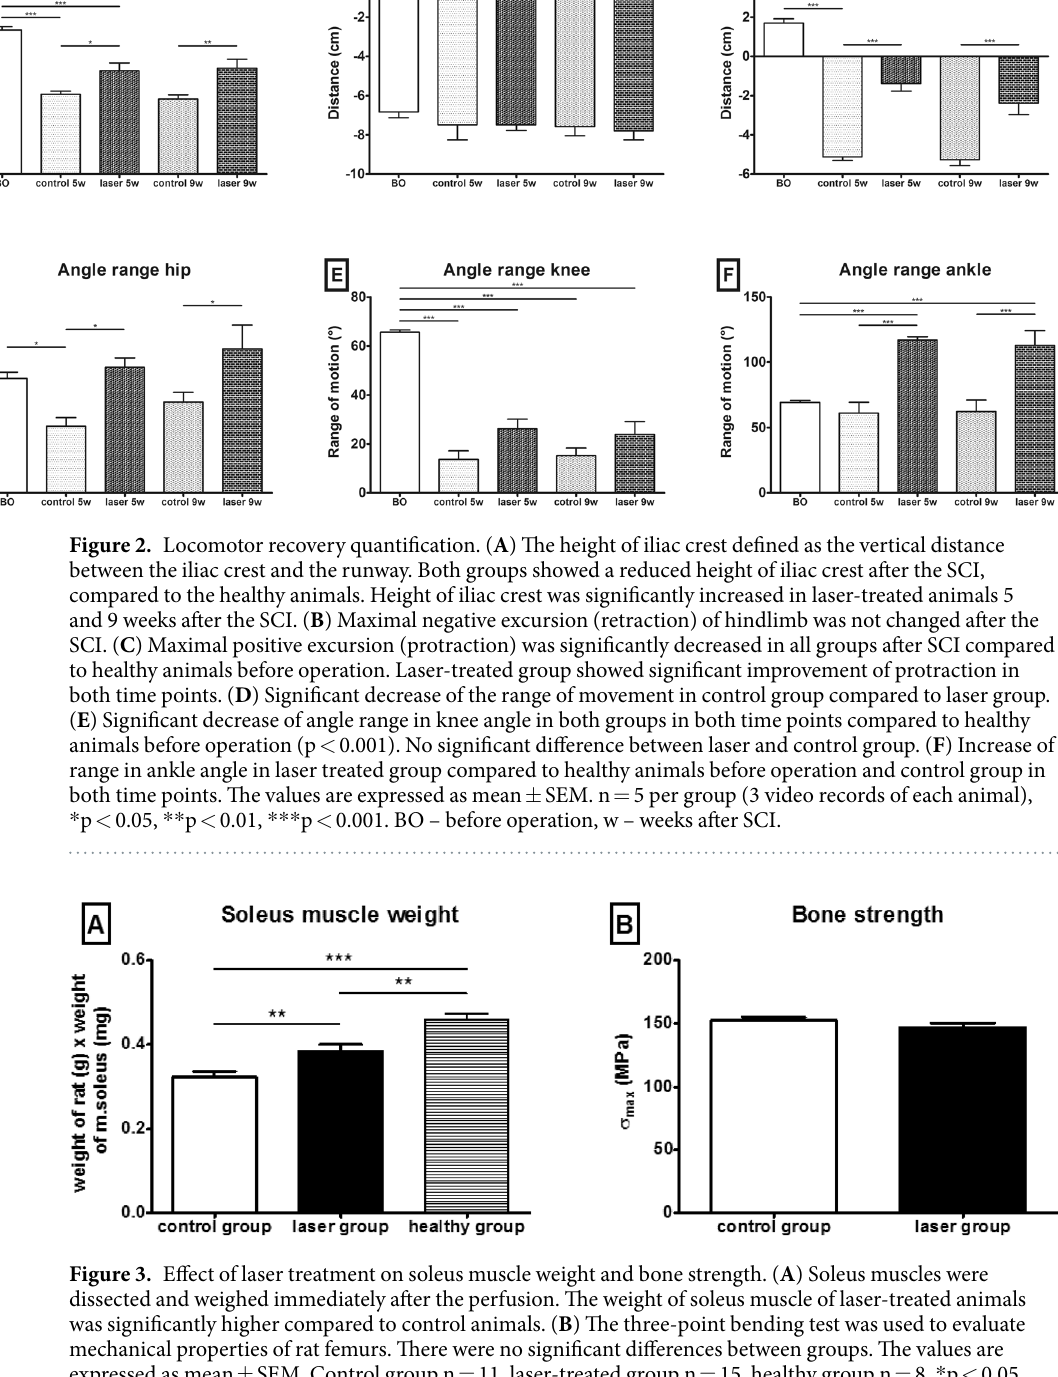
Axonal sprouting. GAP43-staining was used to determine newly sprouted axonal fibers. We did not observe any significant difference in the laser-treated group in comparison with the control group (Fig. 6).